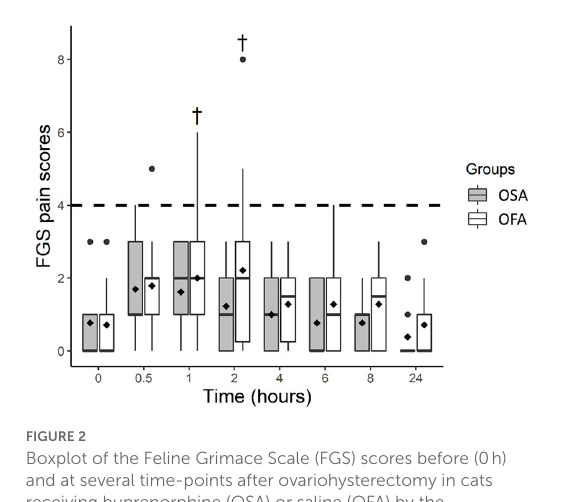
FIGURE2 Boxplot of the Feline Grimace Scale (FGS) scores before (0h) and at several time-points after ovariohysterectomy in cats receiving buprenorphine (OSA) or saline (OFA) by the intramuscular route in combination with ketamine-dexmedetomidine-midazolam and multimodal analgesia. • indicates outliers; (cid:7) indicates mean; † indicates a significant difference when compared with baseline values (0h); the dotted line indicates the analgesic threshold of the FGS.